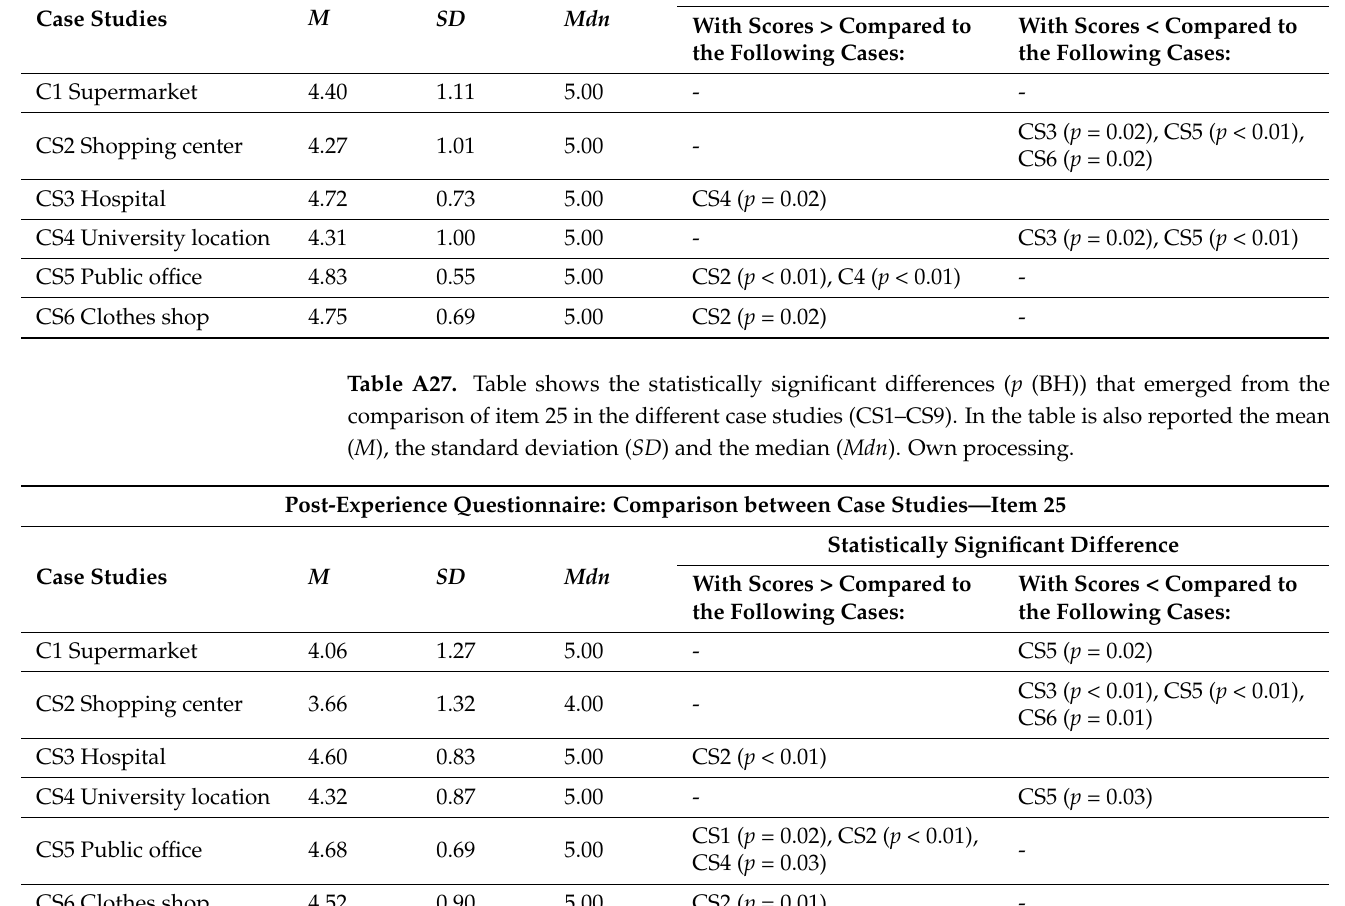
Table A28. Table shows the statistically significant differences ( p (BH)) that emerged from the comparison of item 26 in the different case studies (CS1–CS9). In the table is also reported the mean ( M ), the standard deviation ( SD ) and the median ( Mdn ). Own